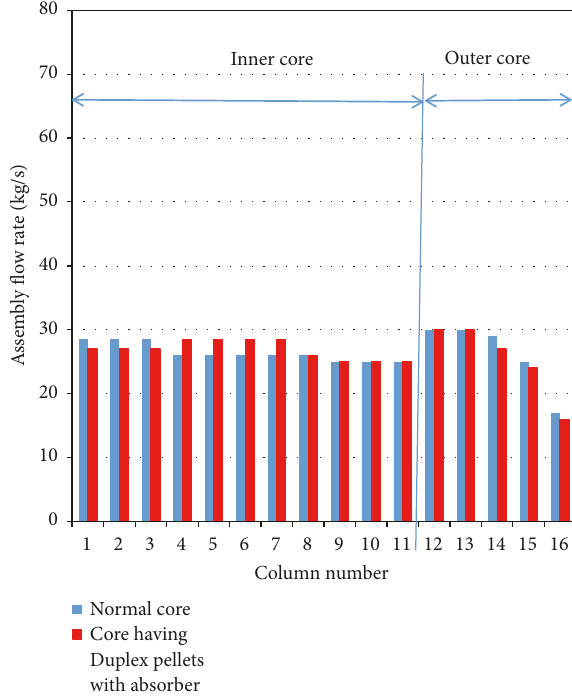
Figure 5: Comparison of assembly flow rate between the normal core without Duplex pellets and the core having Duplex pellets with neutron